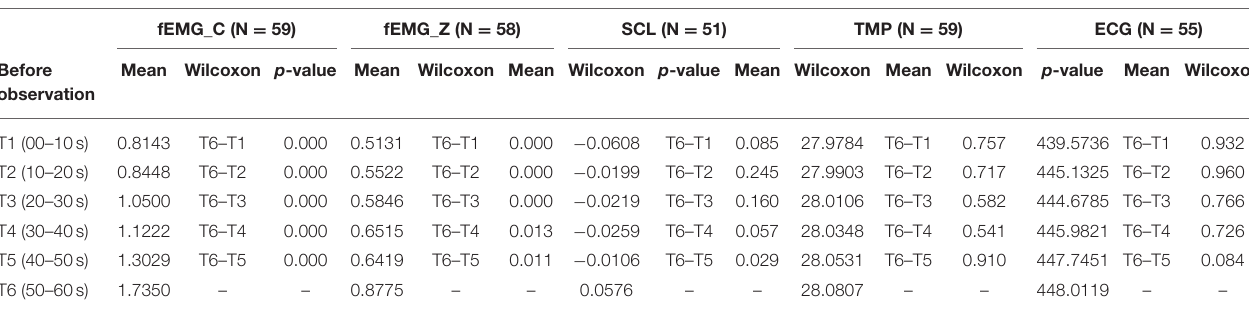
TABLE 3 | Autonomous sympathetic activity before paralinguistic observation to six events T1-5 vs. T6. fEMG_C (N = 59) fEMG_Z (N = 58) SCL (N = 51) TMP (N = 59) ECG (N =